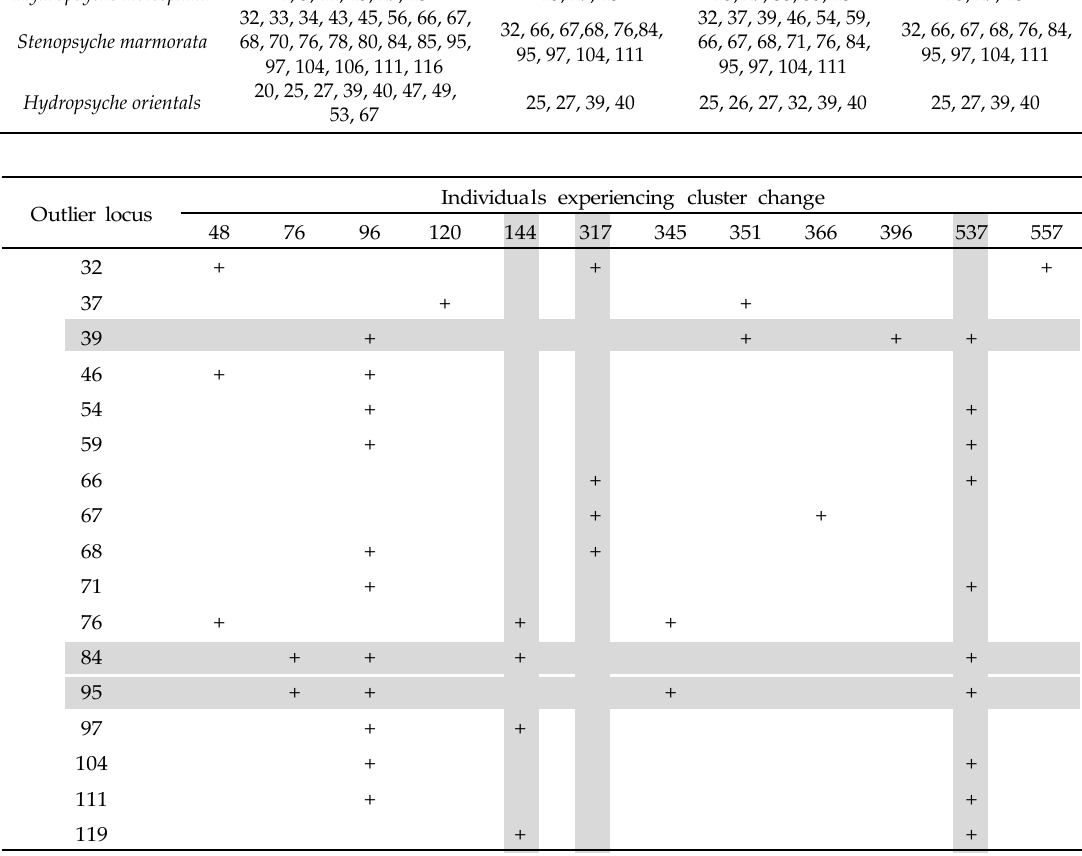
Figure A4. List of loci and individuals showing discrete values in cluster distance in Stenopsyche marmorata . Overlapping with four or more loci (or individuals) is represented by horizontal (or vertical) gray bars. The number of individuals is arbitrarily given.